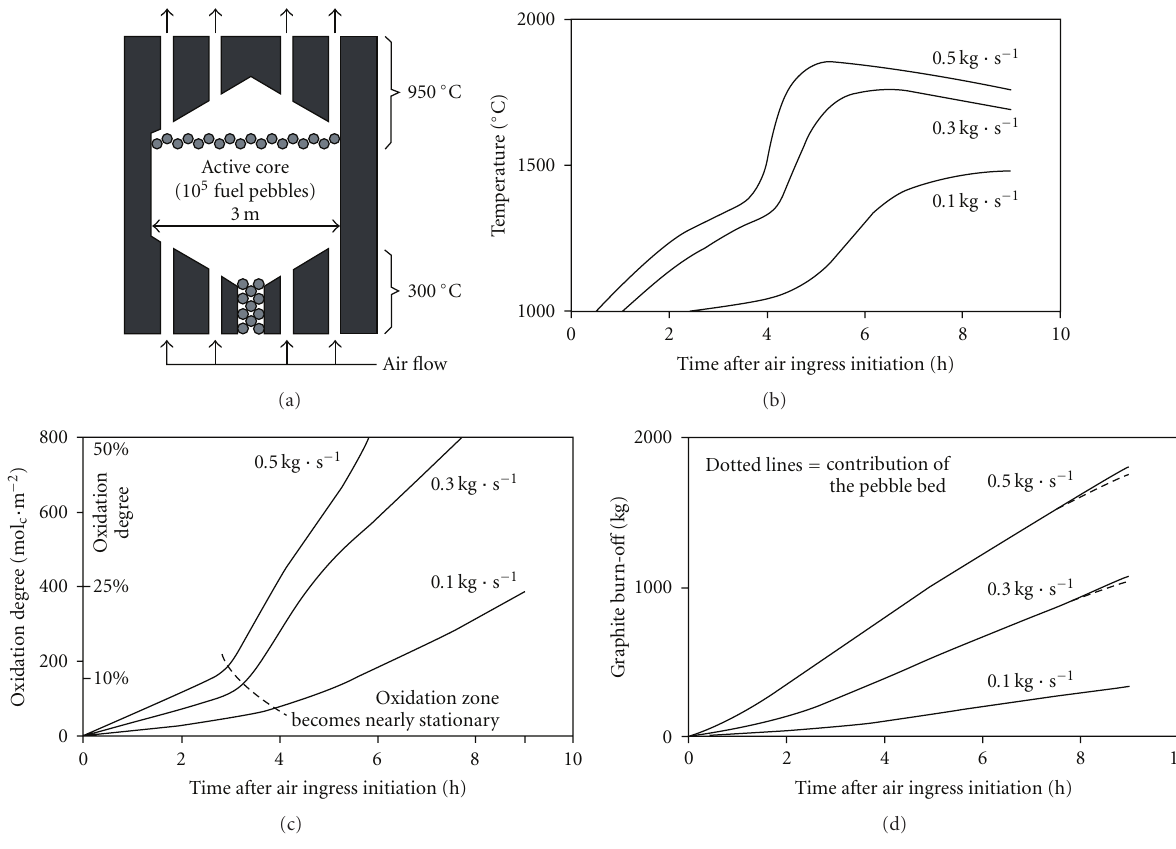
Figure 12: (a) Schema of AVR with flow pattern in air ingress. (b) Calculated maximum temperatures in AVR air ingress at di ff erent air flow. (c) Calculated maximum oxidation degree (burn-o ff ) of fuel elements in AVR air ingress for di ff erent air flow. (d) Calculated total and pebble bed burn-o ff in AVR air ingress for di ff erent air flow.